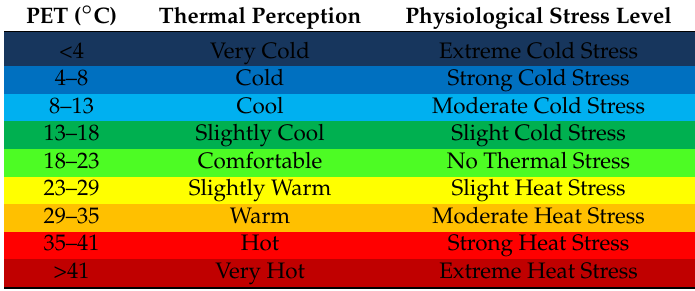
Table 2. Threshold values of Physiologically Equivalent Temperature (PET) for different grades of thermal sensation and physiological stress on human beings, during standard conditions [22]. PET ( ◦ C) Thermal